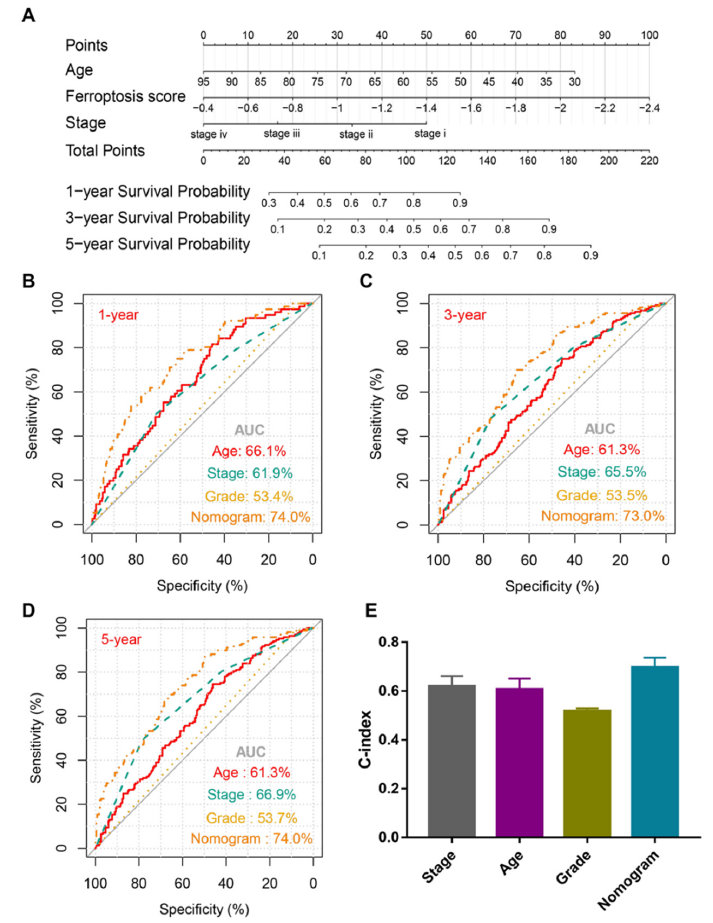
Figure 5. Construction and evaluation of a predictive nomogram in the TCGA cohort. ( A ) Nomo- gram based on ferroptosis score and clinicopathologic factors for OS prediction of BCa patients. ( B – D ) ROC curve of 1-, 3-, and 5-year OS prediction based on the prognostic nomogram, respectively. ( E ) Comparation of C-index among nomogram, patient age, tumor stage, and tumor grade. TCGA, The Cancer Genome Atlas; OS, overall survival; BCa, bladder cancer; ROC, receiver operating characteristic; AUC, area under curve; C-index, concordance index.